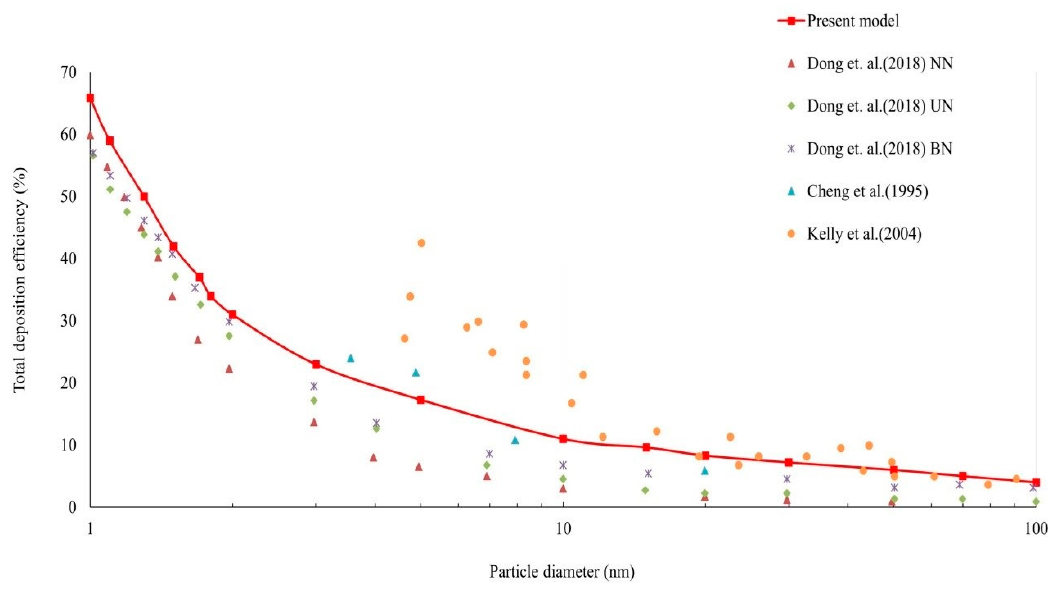
Figure 11. Total nanoparticle deposition curve and its comparison with the data from works of Dong et al. [10], Kelly et al. [23] and Cheng et al.